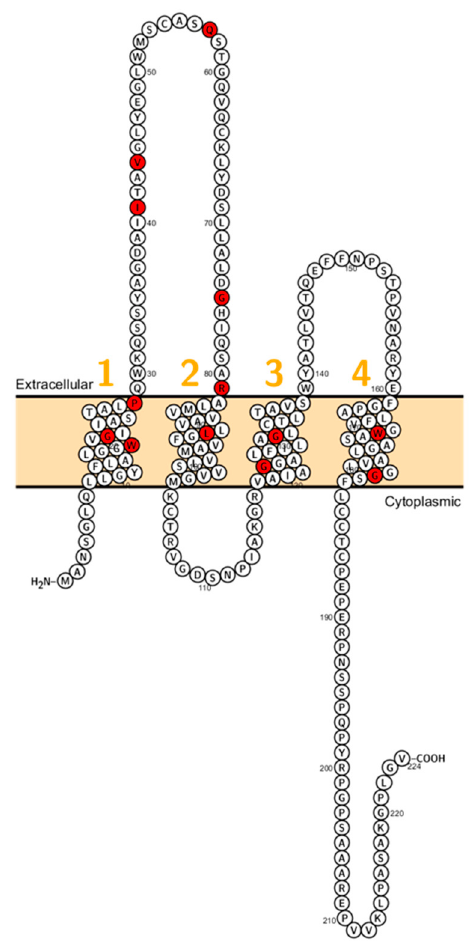
Figure 7. Topology of CLDN19 . FASTA sequence of CLDN19 (Uniprot accession no: Q8N6F1). Each amino acid is shown as a single letter code and numbers (orange) indicate transmembrane domains. Mutations shown to be involved in human diseases are shown in red.